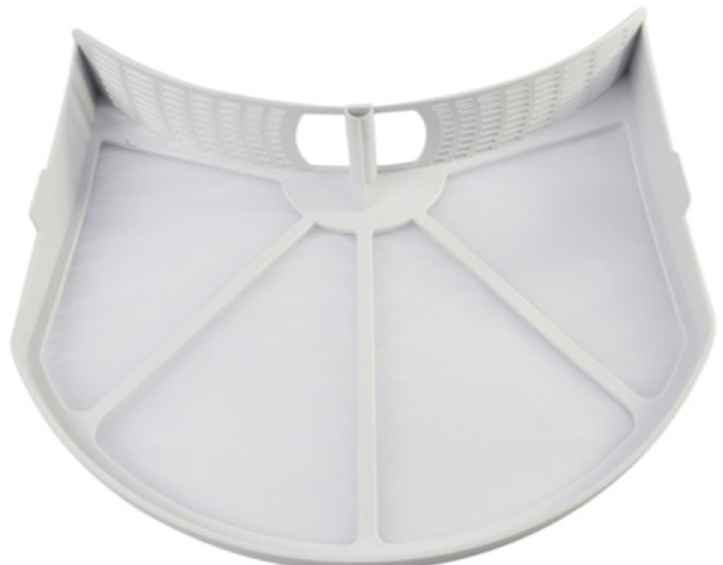
Fig 2. Lint filter device from Indesit tumble dryer. Lint filter component as purchased. During the drying cycle, fibers accumulate on the white mesh regions which are supported by a plastic frame.